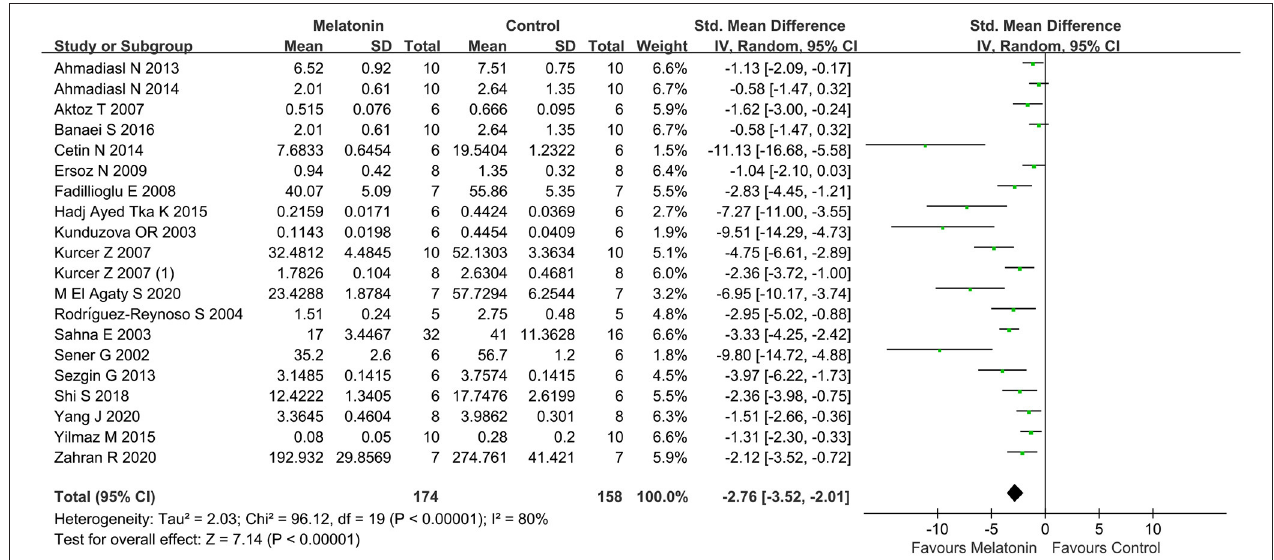
FIGURE 4 | Forest plot for the effects of melatonin on malondialdehyde.